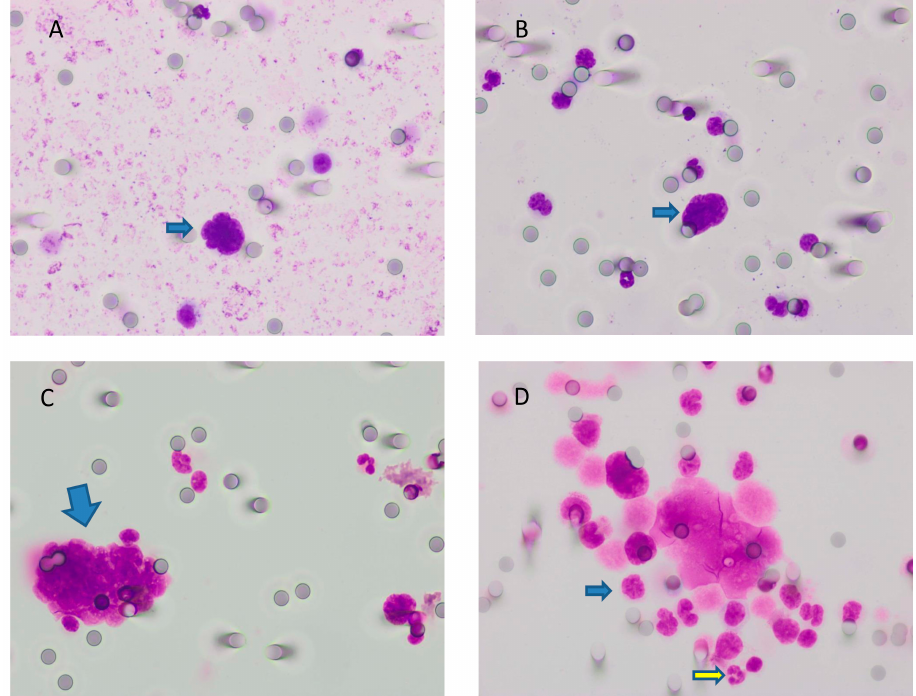
Figure 4. Comparison of positive ( A – C ) and negative findings ( D ) for CTC visualized by May–Grünwald–Giemsa (MGG) staining at 40 × magnification. ( A ) Naked nucleus (without cytoplasm), intensely stained (hypercromatic), with irregular shape and scalloped borders, suspect for carcinoma. The absence of a clearly visible cytoplasm did not permit the evaluation of the nuclear / cytoplasmic ratio. ( B ) The same as the previous image; herein, we can compare the size of the naked nucleus (arrow) with the size of neighboring leukocytes (around 3–4 times bigger). ( C ) A cluster of cells with a high nucleus / cytoplasm ratio, hypercromasia, and irregular shape of nuclei. Additionally, cells were bigger than leukocytes. ( D ) Some of the cells in this sample were degenerated. We did not take into account these cells. The remaining population (for example, the cell indicated by the blue arrow) had a nuclear size somewhat similar to that of leukocytes (yellow arrow). Where cytoplasm was present, it was granular. Thus, all of these cells were probably leukocytes. * CTC = circulating tumor cells; MGG = May–Grünwald–Giemsa.